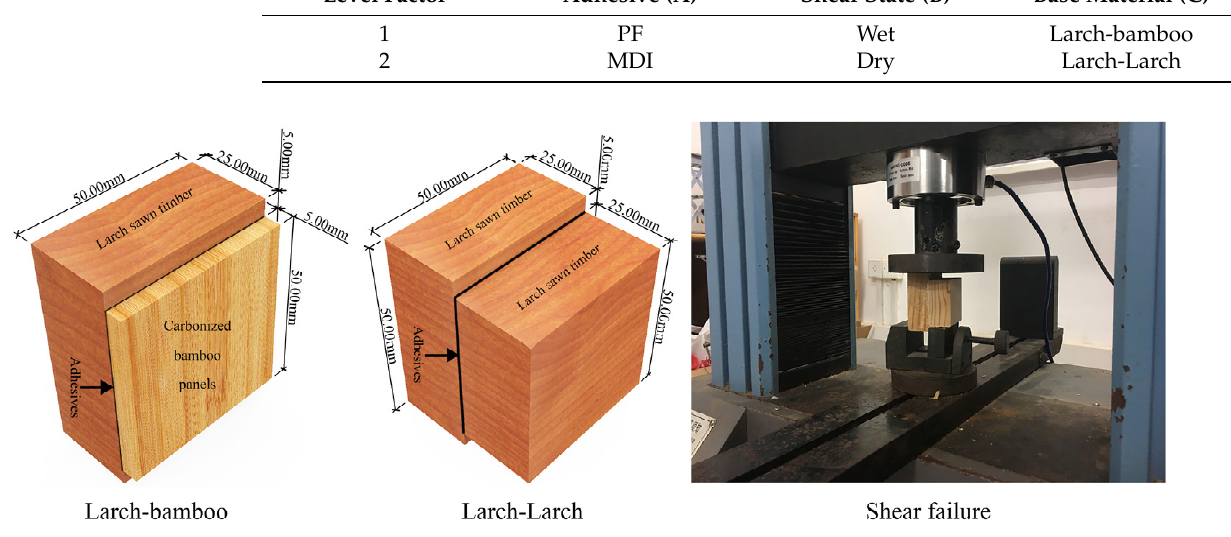
Table 1. Variation and experimental level of specimen.